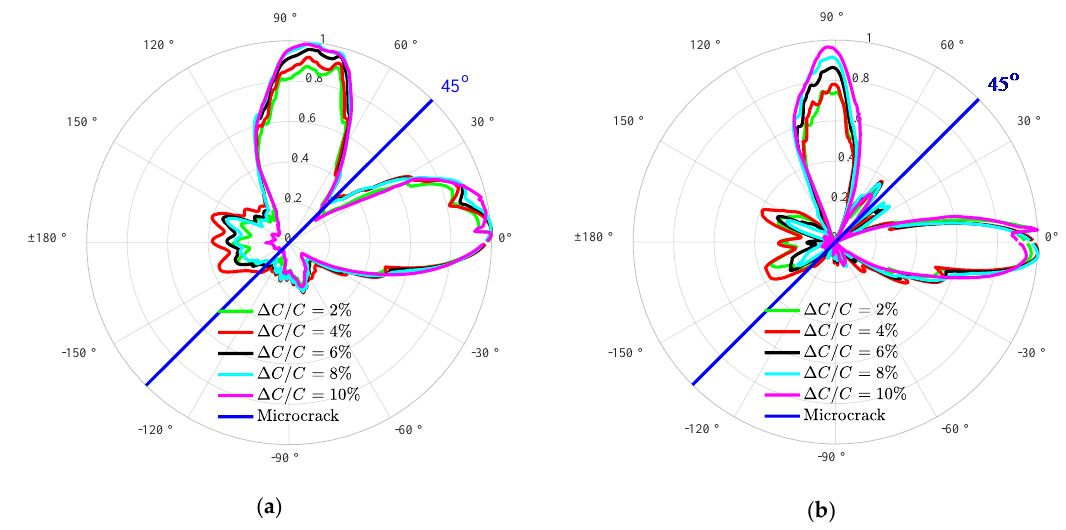
Figure 6. Normalized directivity of the radial ( a ) and circumferential ( b ) second harmonic amplitudes under different stiffness difference Δ C C (from 2% to 10%).